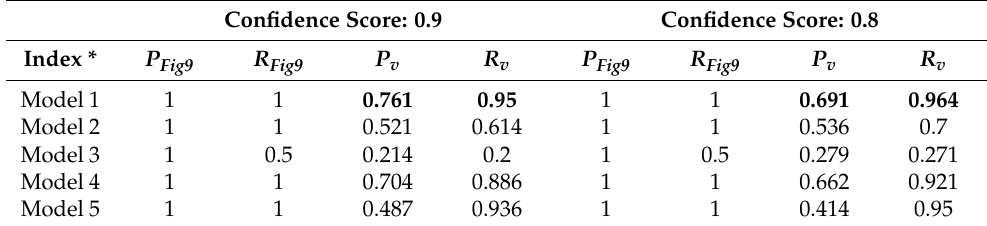
Table 7. Comparison of the experiment results between Figure 9 and validation set.